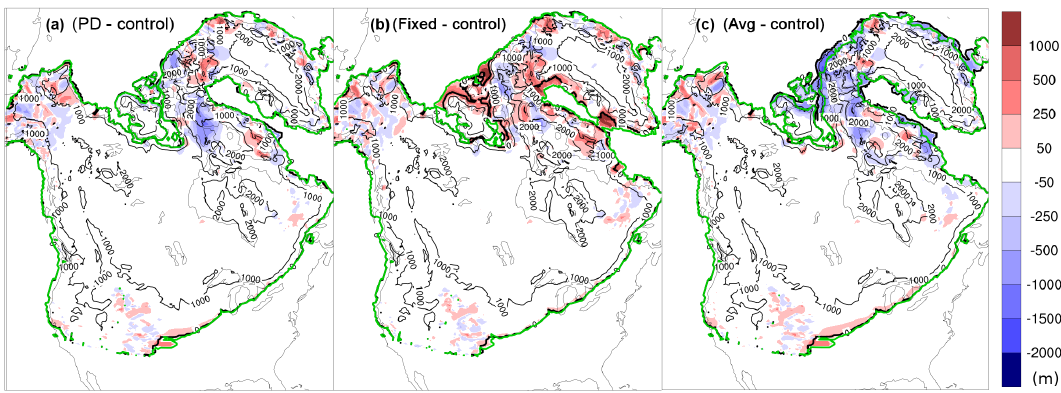
Figure 6. Ice thickness difference from the control run (dynamic ocean temperature) at 108ka for three test runs starting from the same 110ka control run restart. The three test runs are as follows: (a) PD ocean temperature run, (b) the fixed ocean temperature at − 2 ◦ C run, and (c) the temperature averaged over ocean layers run. Contours show the ice thickness in the control run. Thick black and green contours show the ice margin in the control and the other run in each of the panels, respectively.